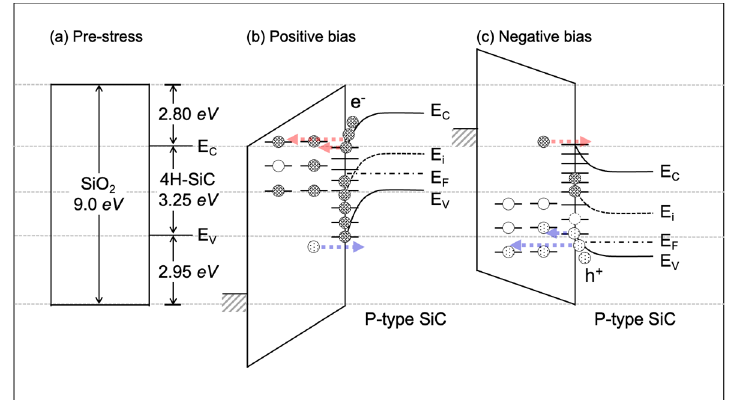
Figure 5. Energy band diagrams of MOS structure under ( a ) equilibrium; ( b ) positive; ( c ) negative bias conditions showing tunneling of electrons and holes in either direction.